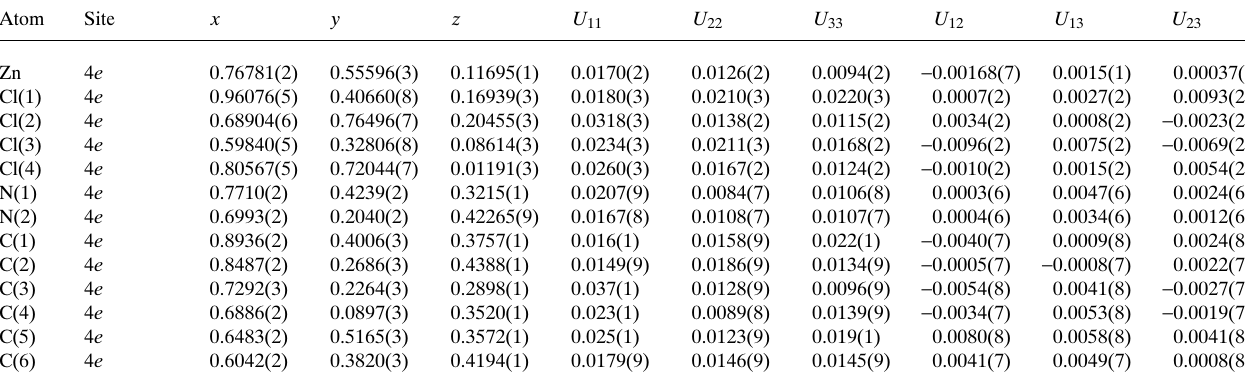
Table 3. Atomic coordinates and displacement parameters (in Å 2 ) .